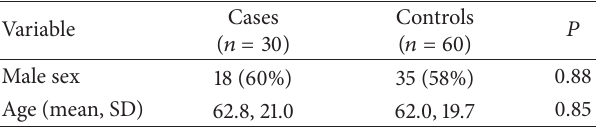
Table 1: Characteristics of VRE cases and